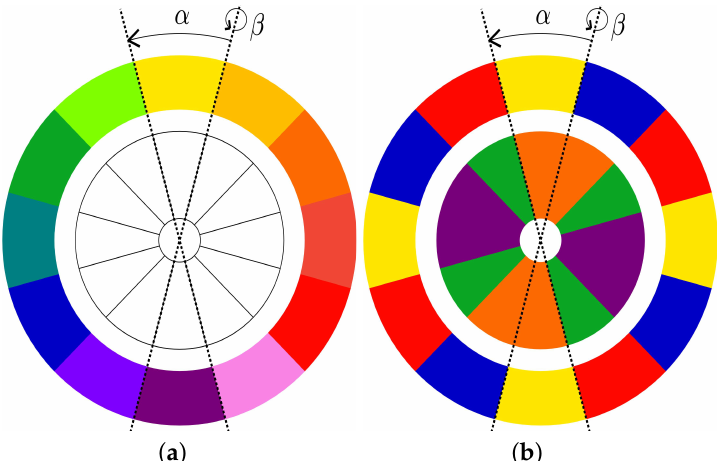
Figure 2. Symmetry and color symmetry on a color wheel with 12 slots. We denote the slots according to the digits of a clock face. Axes connect slots on the right-hand side of each slot. A rotation α rotates counter-clockwise with 30 ◦ , and a reflection β reflects in the axis connecting 12 and 6 o’clock. ( a ) The outer circle is the RYB (red–yellow–blue) color wheel. ( b ) Color symmetry described by the color permutations of Equation (1) (outer circle) and Equation (2) (inner